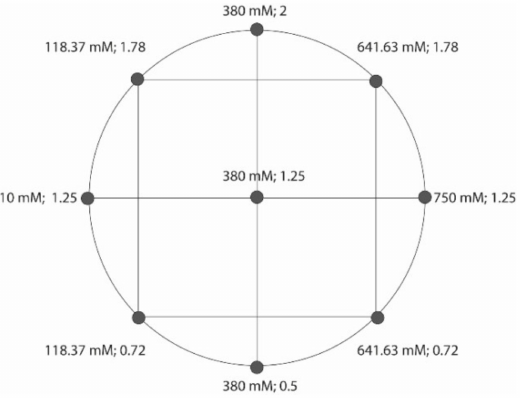
Figure 2. Box-Hunter design matrix representing the butyric acid concentration and acid:alcohol molar ratio used to maximise single-batch and cumulative